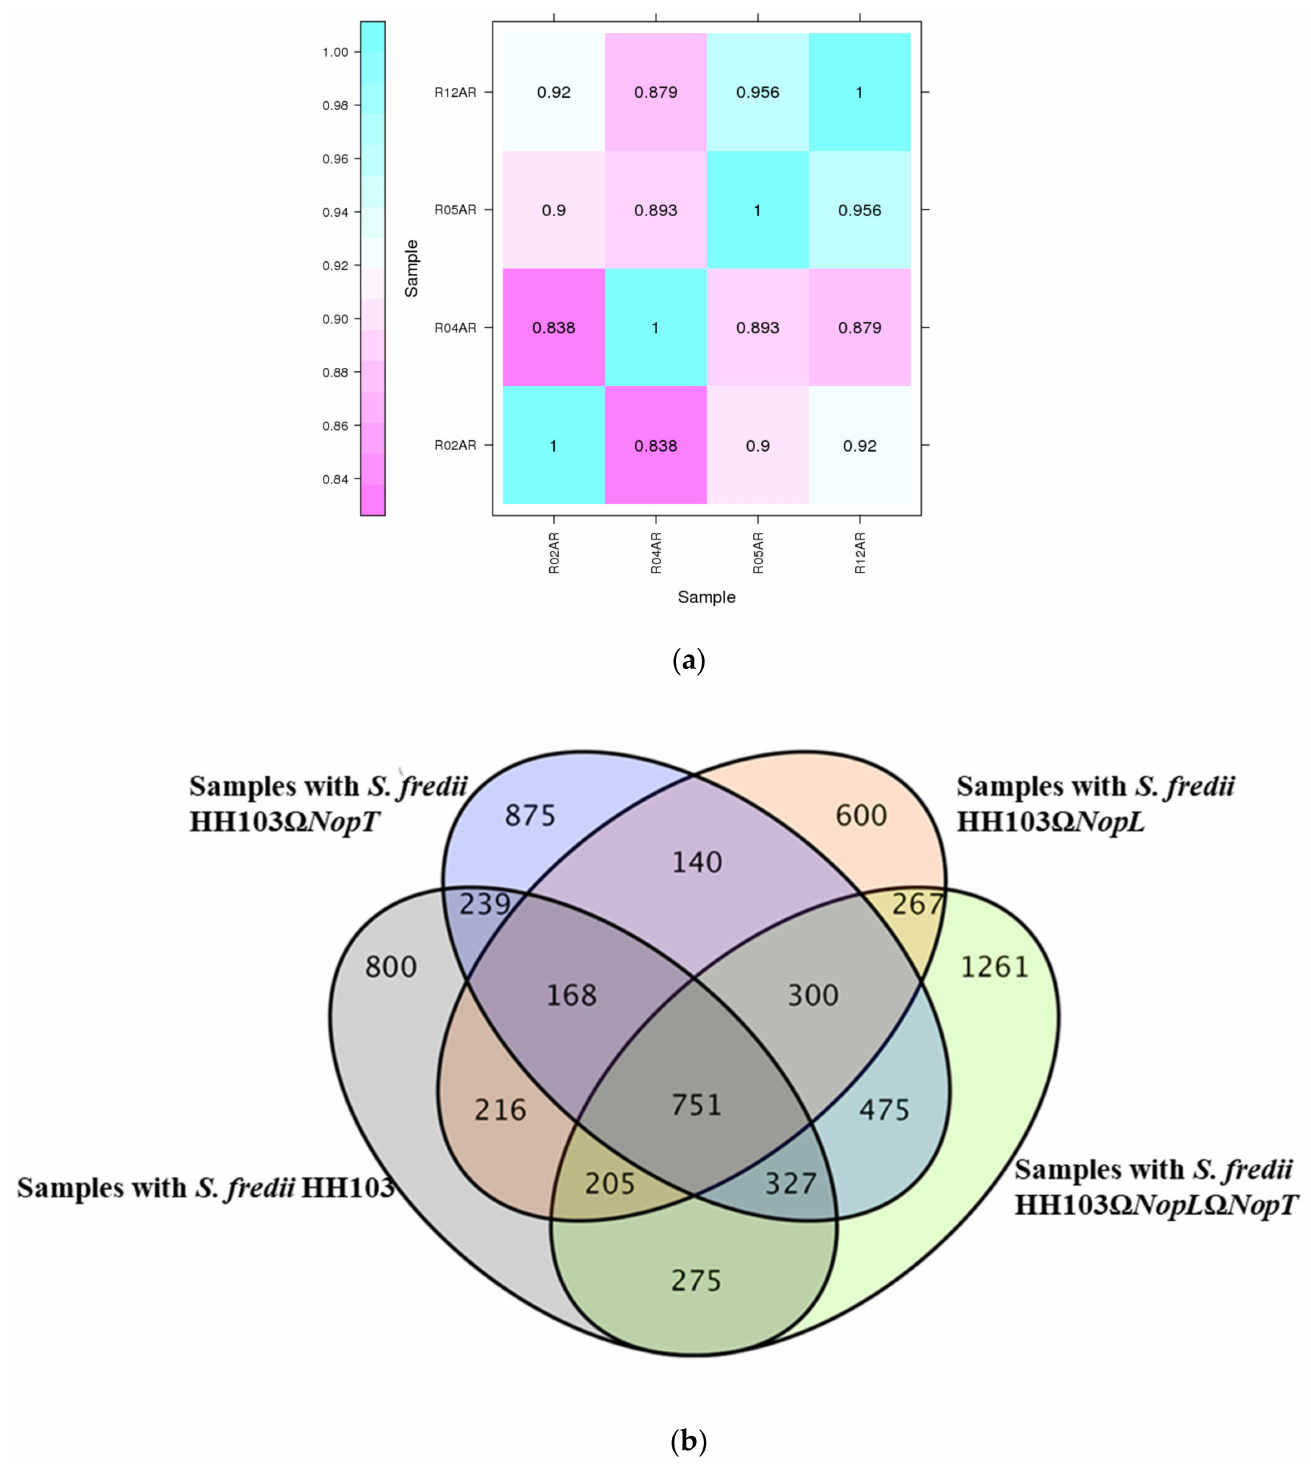
Figure 3. Transcriptomic analysis of roots of soybean inoculated with S. fredii HH103 and mu- tants: ( a ) Pearson correlation coefficients of all RNA-seq libraries; ( b ) Venn diagram showing the differentially expressed genes (DEGs) in the samples inodulated with different